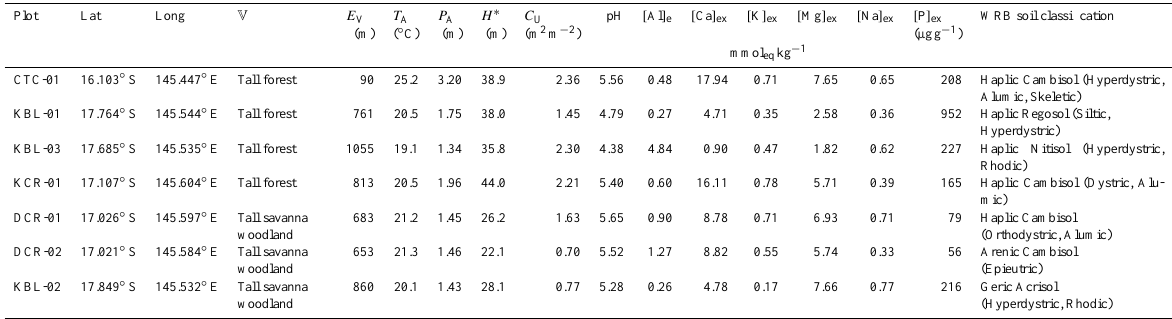
Table 2. Plot coordinates after Torello-Raventos et al. (2013), vegetation classification V , elevation a.s.l. E V , mean annual temperature T A , mean annual precipitation P A , 0.95 quantile upper stratum canopy height H ∗ , upper stratum canopy area index C U , soil pH, soil exchangeable cations, soil extractable phosphorus and World Reference Base (WRB) soil classification for the study site’s soil values represent the top 0.3m of